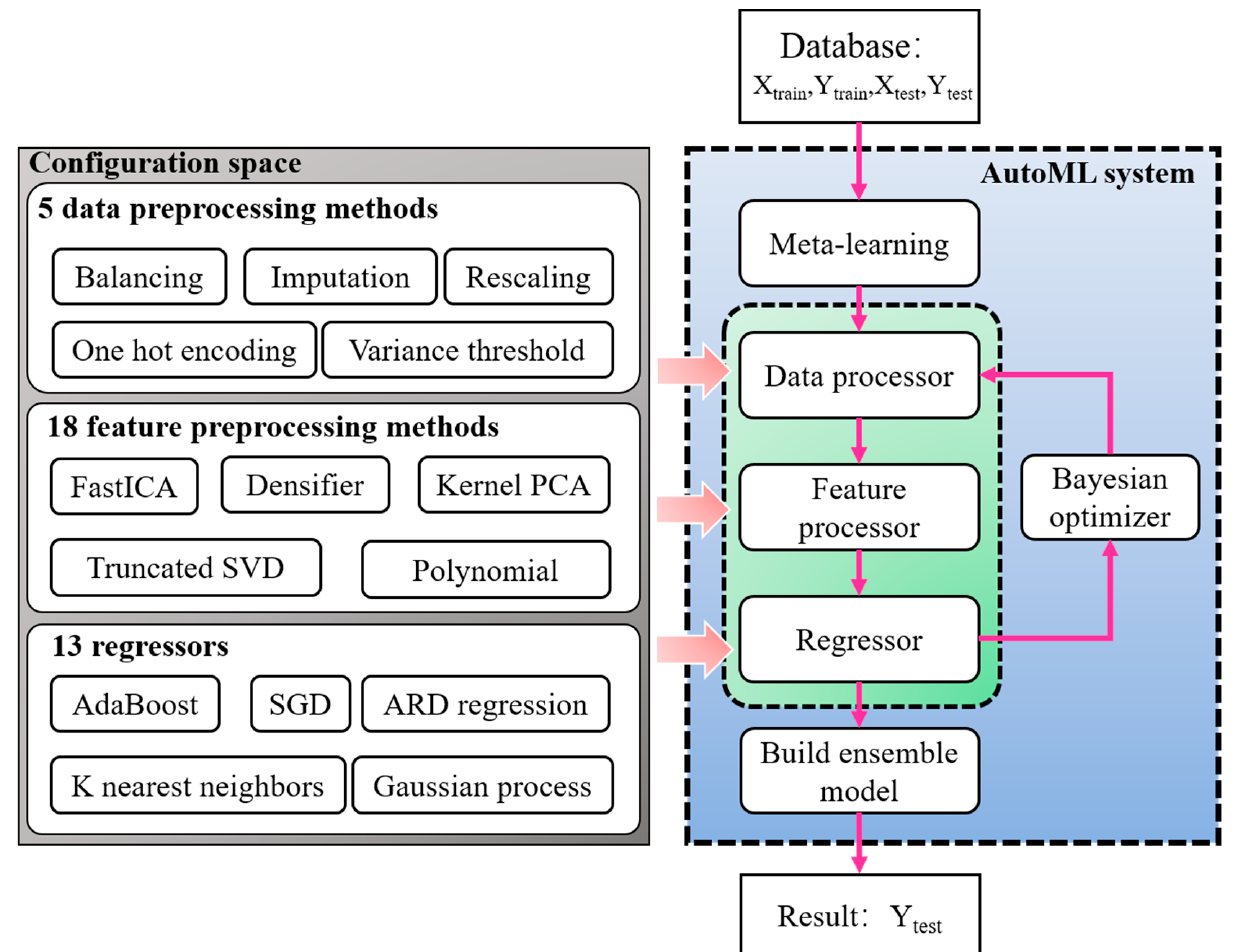
Figure 6. Auto-Sklearn algorithm framework.